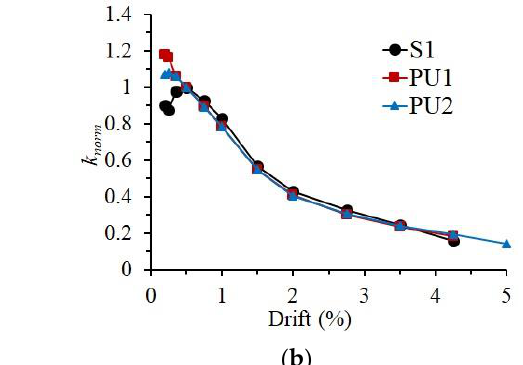
ergy dissipation of structures or components is usually evaluated by two different indices, the equivalent viscous damping ratio ( ζ eq ) and cumulative dissipated energy. As the test specimens in this paper were manufactured at different times, the values of ζ eq were cal- culated and utilized in this investigation, which equaled the result of dividing the dissi- pated energy in one hysteresis loop by the product of the dissipated energy in an equiva- lent linear system and a constant, 2 π [ 23]. Figure 11 exhibits the relationship between the ζ eq values of the three specimens and the number of loading cycles. The variation charac- teristics of the presented curves of the three specimens were relatively close, showing a similar developing process of the energy dissipation capacity as the loading process. Ex- cept for the failure stage, the equivalent viscous damping ratio of Specimen S1, due to the better integrity, was marginally higher than those of Specimens PU1 and PU2, showing a relatively better capacity of energy dissipation. In the failure stage, the ζ eq values of Spec- imens PU1 and PU2 became comparable with that of Specimen S1, and the total number of loading cycles was also larger than that of Specimen S1. This revealed that the prefab- ricated UHPC shells were able to increase the energy dissipation capacity of the precast specimens at the failure stage. The ζ eq values of Specimen PU2 remained greater than those of Specimen PU1 in the main loading stage, indicating that the longer UHPC shell was more helpful for improving the energy dissipation capacity.